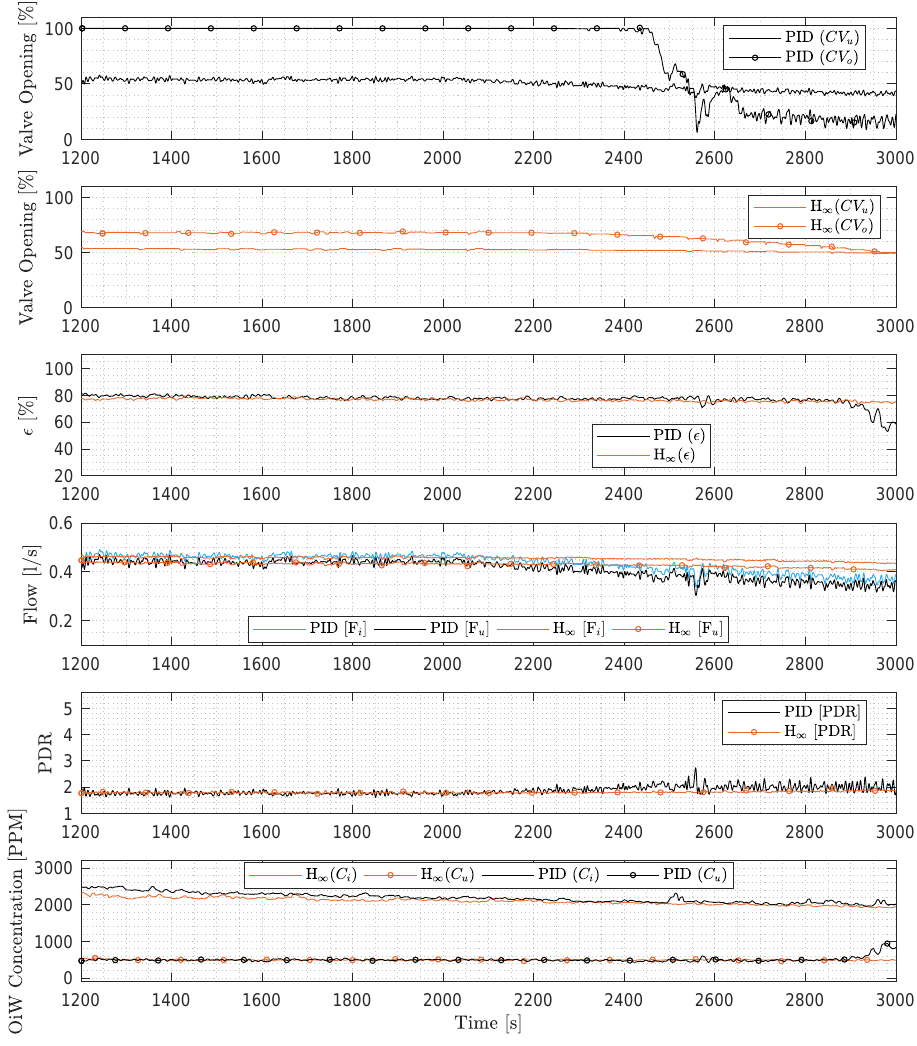
Figure 7. Experiment Results: controller evaluation with constant inlet flow rate at 1000–2000 s at 0.47 L/s, followed by a linearly decreasing flow, from 0.47 to 0.37 L/s, 2000–3000 s. The plots show valve openings, efficiencies, flows, PDRs, and OiW